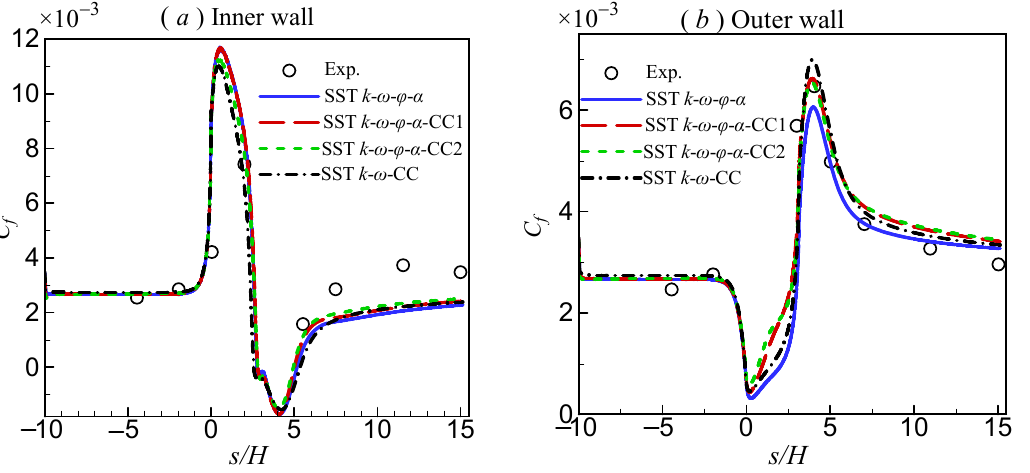
Figure 9. Comparison of friction coefficient distribution along the ( a ) inner and ( b ) outer walls. Overall, for the 2D U-turn duct flow, the three models with streamline curvature correc- tion provided some improvements. However, it is difficult to determine which performed the best. For example, considering the velocity profile s / H = π , the result of the STT k - ω -CC model was the best; meanwhile, for the velocity profile s / H = π + 2, the result of the STT k - ω -CC model was not good as those of the two proposed models. It should be noted that the results yielded by the STT k - ω -CC model in this paper were very different from those reported in Smirnov and Menter [3]. The reasons for this phenomenon may be multi-faceted. For example, the different calculation methods for the second derivative, the different treat- ment methods for wall boundary conditions, and the different computational platforms. The specific reason should be determined in future